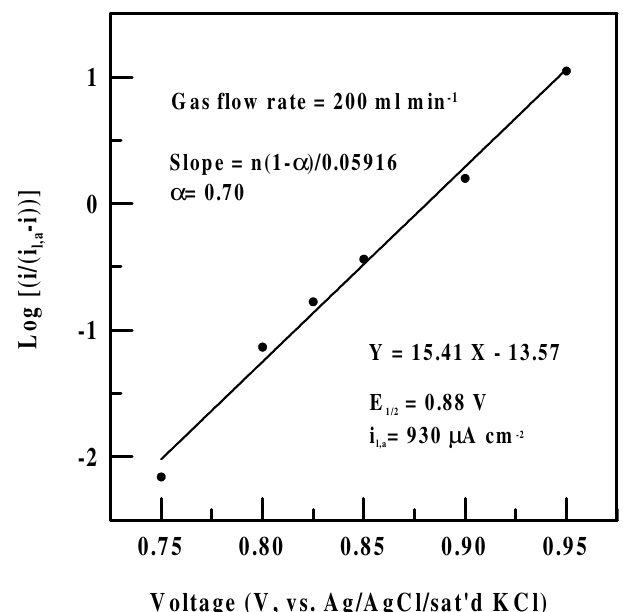
-i)] vs. E, from which the value of a can be obtained from the slope Figure 5 . A plot of log [i/(i l,a and the value of E from the 1/2